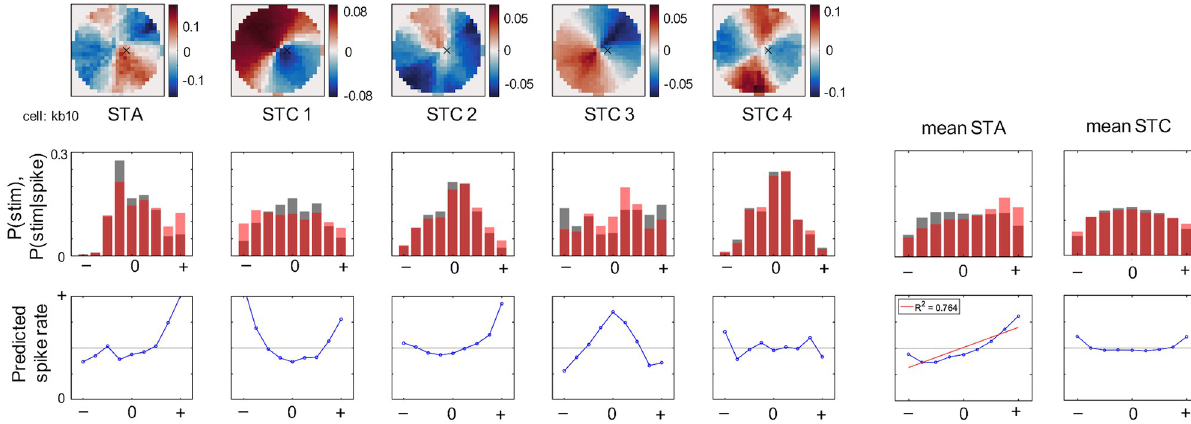
Fig 8. Estimated spike rates and the linearity of RF-FG STA and RF-FG STC s. The top row shows the estimated RF-FG STA and RF-FG STC s for an example neuron. The same conventions were used as in Fig 2. The middle row shows the distributions of P(stimulus) and P(stimulus|spike) in gray and red bars, respectively. The classes indicate the stimuli in the rank order of the responses they evoked (the normalized inner-product between the RF-FG and stimulus). P(stimulus|spike)/P(stimulus) is proportional to P(spike|stimulus) that corresponds to the predicted spike rates which are shown in the bottom rows. The linearity of the spike rates indicates the linearity of the operation of the kernel. The right-most column and the second column from the right show the mean across the RF-FG STC s and RF-FG STA s of all examined neurons, respectively. The mean RF-FG STA shows fair linearity with R 2 = 0.764 (the regression line in red; p < 0.001), while the RF-FG STC does not.